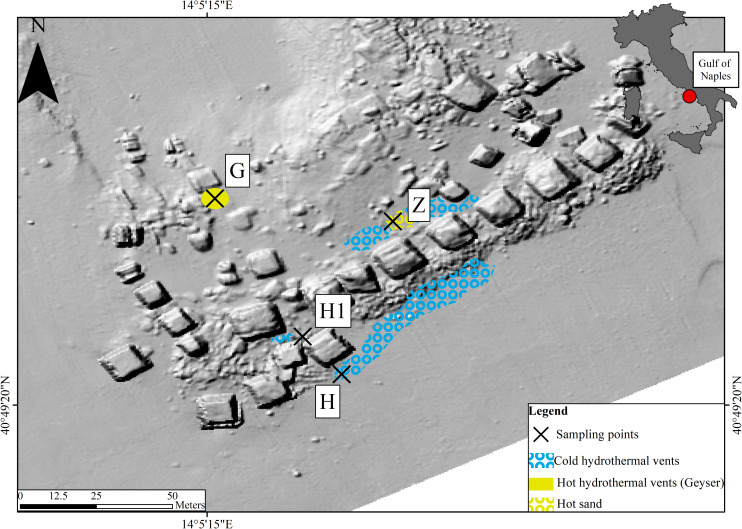
Map of the Gulf of Naples showing locations of the sampling stations.